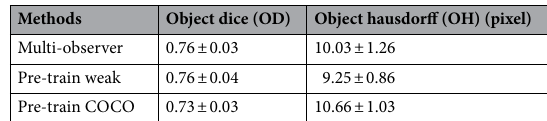
Table 2. Multi-observer validation results for O-test2 dataset.